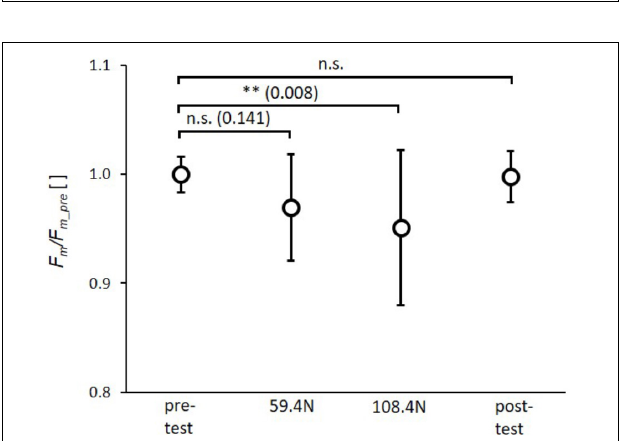
FIGURE 4 | Mean (circles) and standard deviation of maximal force ( F m ) for pretest, loading conditions (59.4 and 108.4 N) and post-test. For each subject F m values of single twitches were normalized by mean subject specific maximal force of pretest ( F m_pre ). ∗ p < 0.05; ∗∗ p < 0.01; ∗∗∗ p < 0.001.